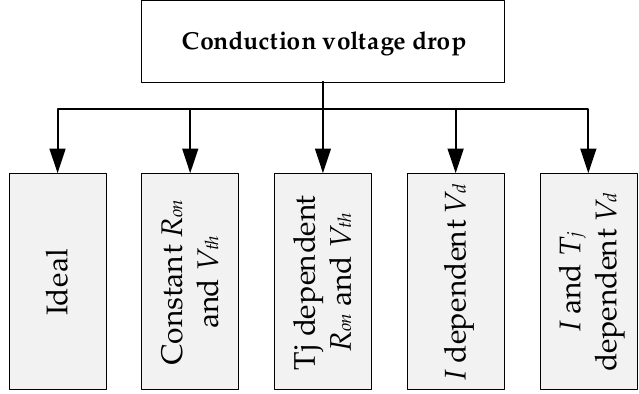
Figure 5. The considered five conduction voltage drop calculation variants.